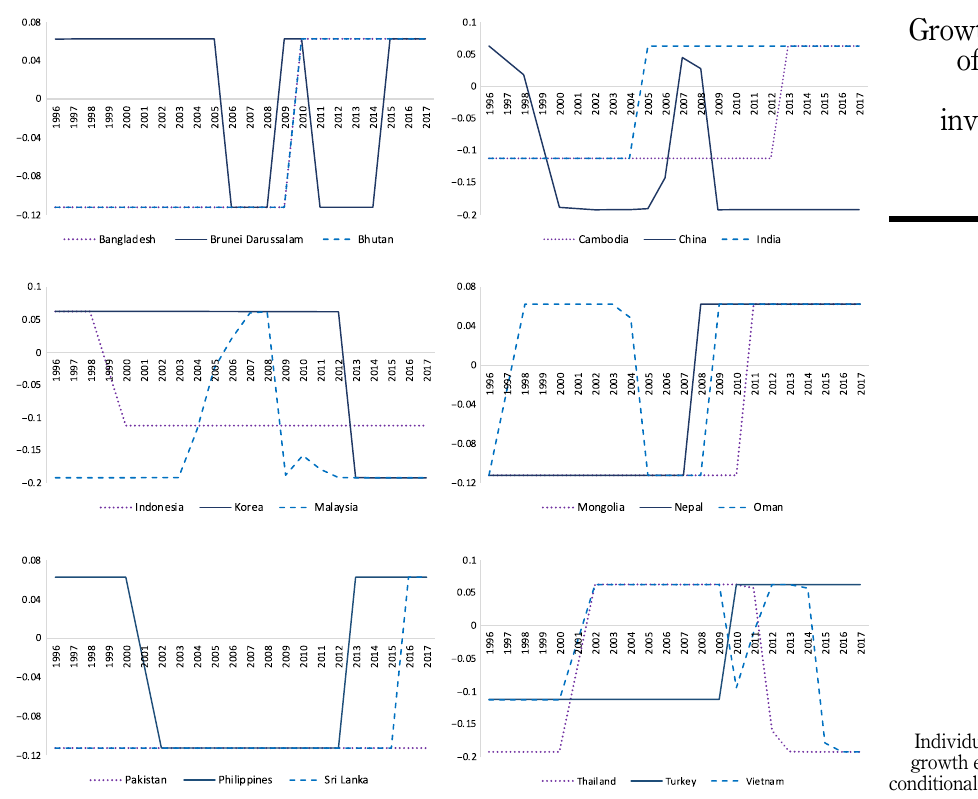
Figure 2. Individual